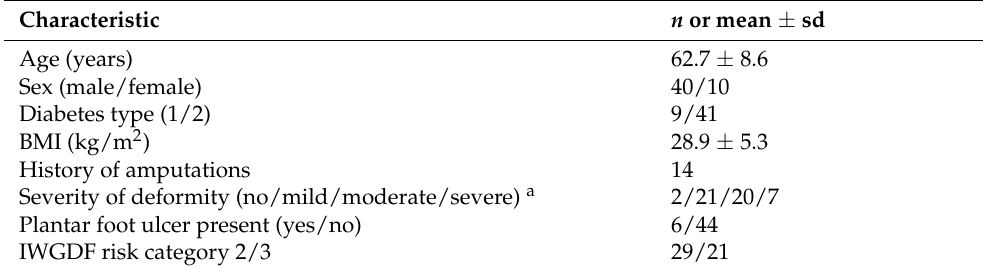
Table 1. Subject Characteristics ( n =